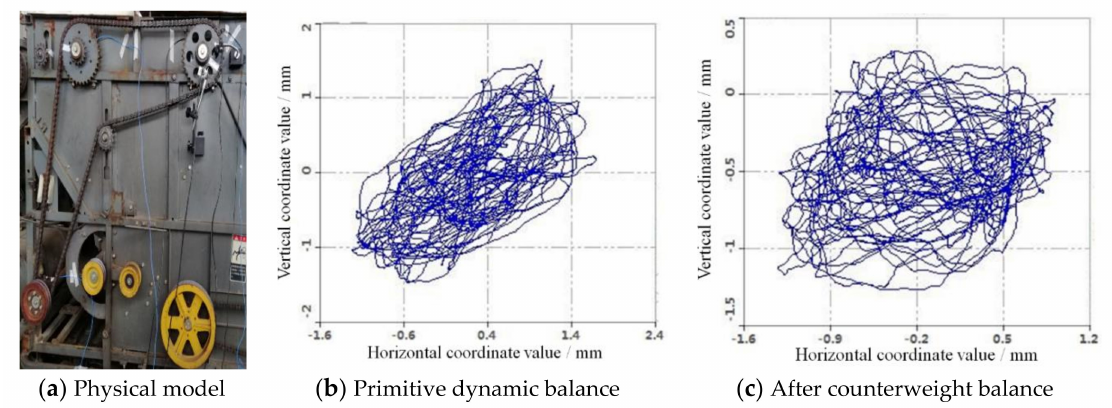
Figure 14. Axial trajectory of single threshing drum